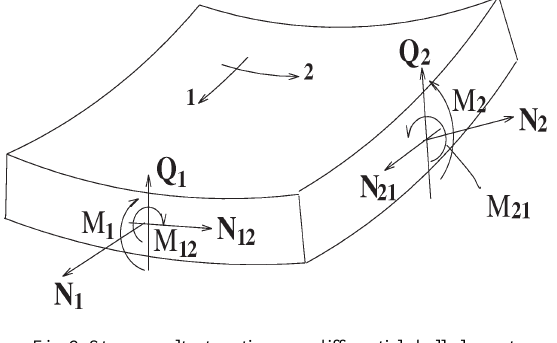
Fig. 2. Stress resultants acting on a differential shell